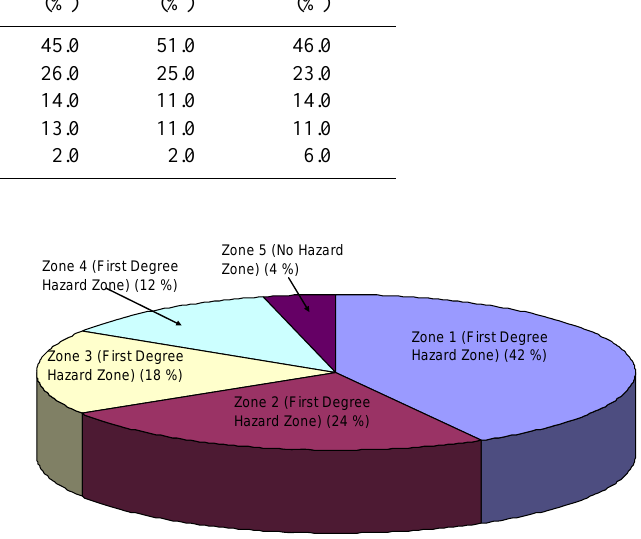
Fig. 3. Distribution of surface area (km 2 ) as related to the earthquake zoning map of Turkey obtained from the “General Management of Disaster Affairs of